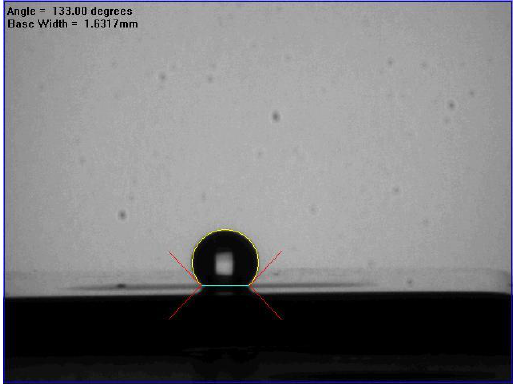
Figure 9. Contact angle measurement with respect to processing time 25 s and electrode distance of 20 mm.